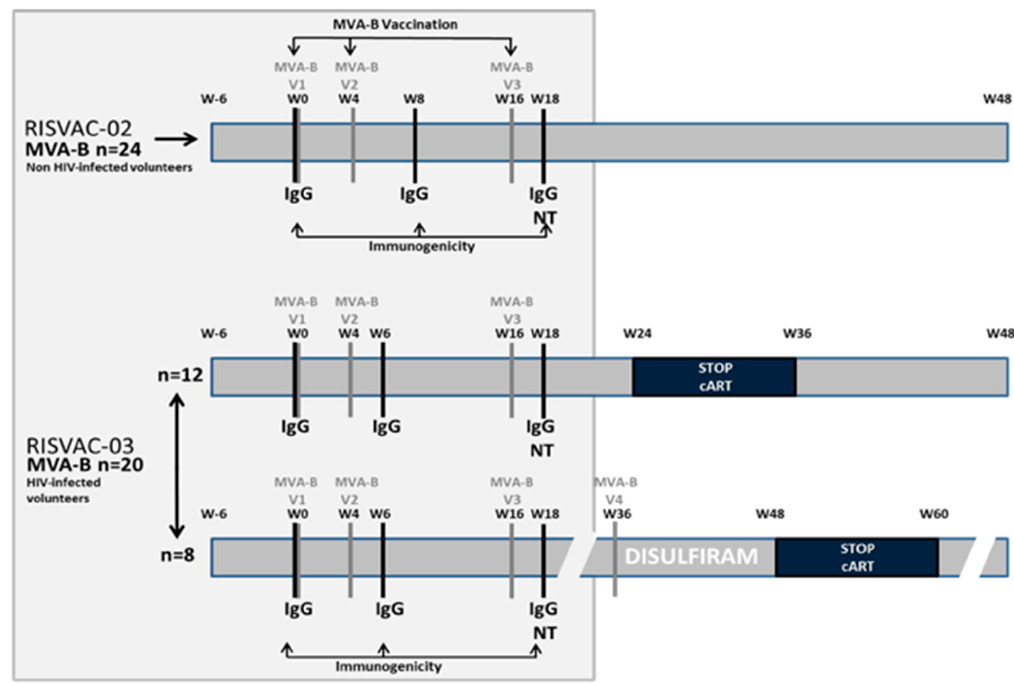
Figure 1. Study design. In this study a comparison of the demographic characteristics, the safety evaluation, and the immunologic response against vaccinia virus (represented inside the grey box) of the 24 non ‐ HIV ‐ infected participants in the modified vaccinia virus Ankara ‐ B: MVA ‐ B arm of the study RISVAC02 against the 20 HIV ‐ infected participants of the MVA ‐ B arm of RISVAC03 was performed. cART: Antiretroviral Therapy. NT: Neutralizing titers.